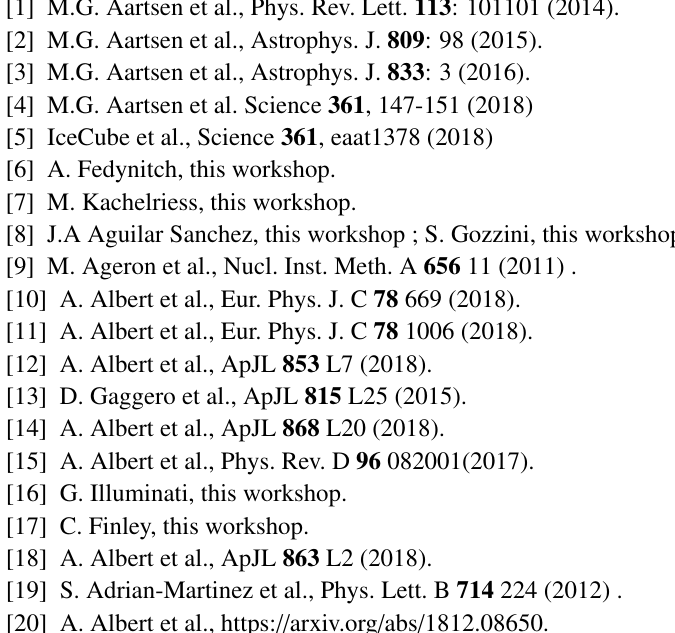
Figure 4. Left: Antares contour at 90% CL in the plane of sin 2 θ 23 and ∆ m 2 the results by several other experiments. Right: 90% (dashed lines) and 99% (solid lines) CL limits for the 3 + 1 neutrino model in the parameter plane of with respect to the non-sterile hypothesis (black lines) and compared to the other